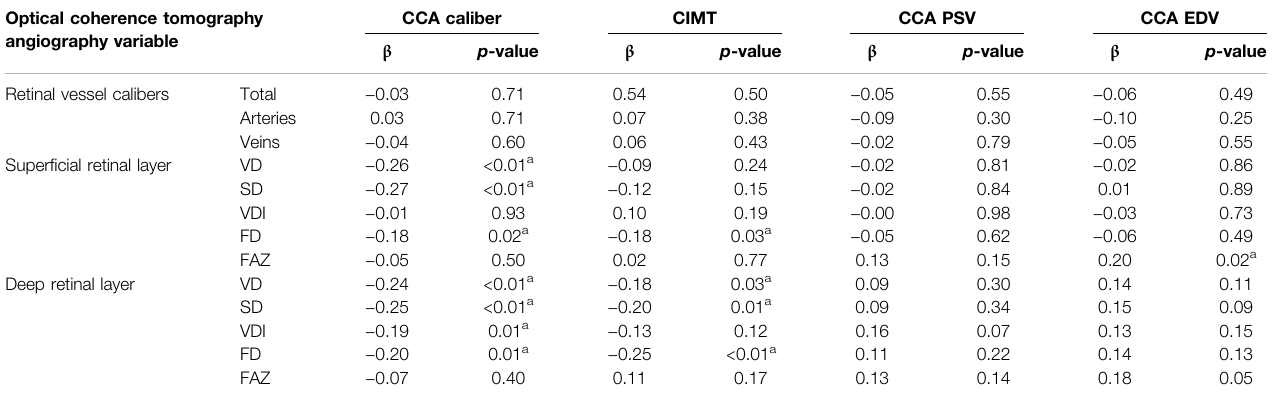
TABLE 4 | Linear regression of ultrasonographical variables on optical coherence tomography angiography-derived data, adjusted for age, sex, and blood pressure. Optical coherence tomography angiography variable